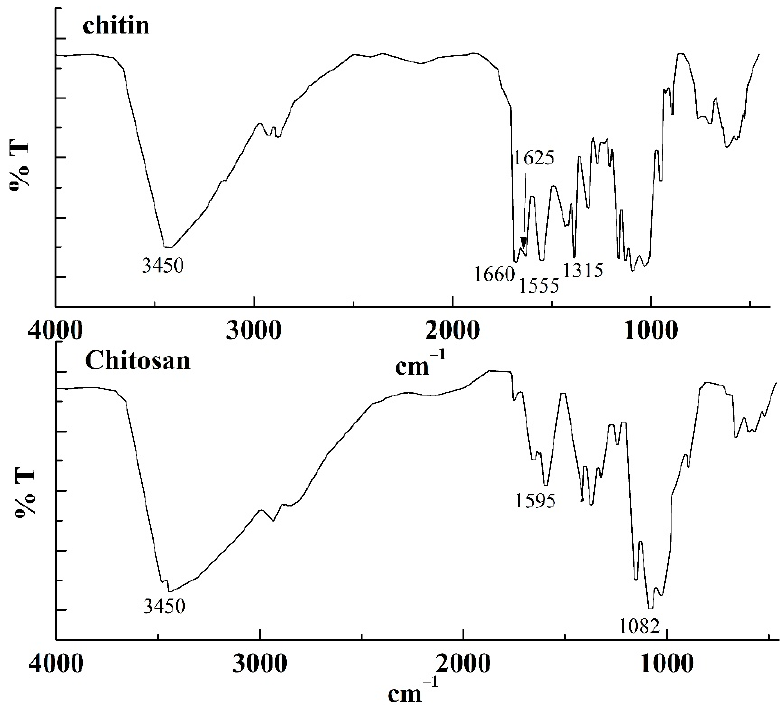
Figure 2. FTIR (Fourier Transform Infrared) spectra for chitin and chitosan.